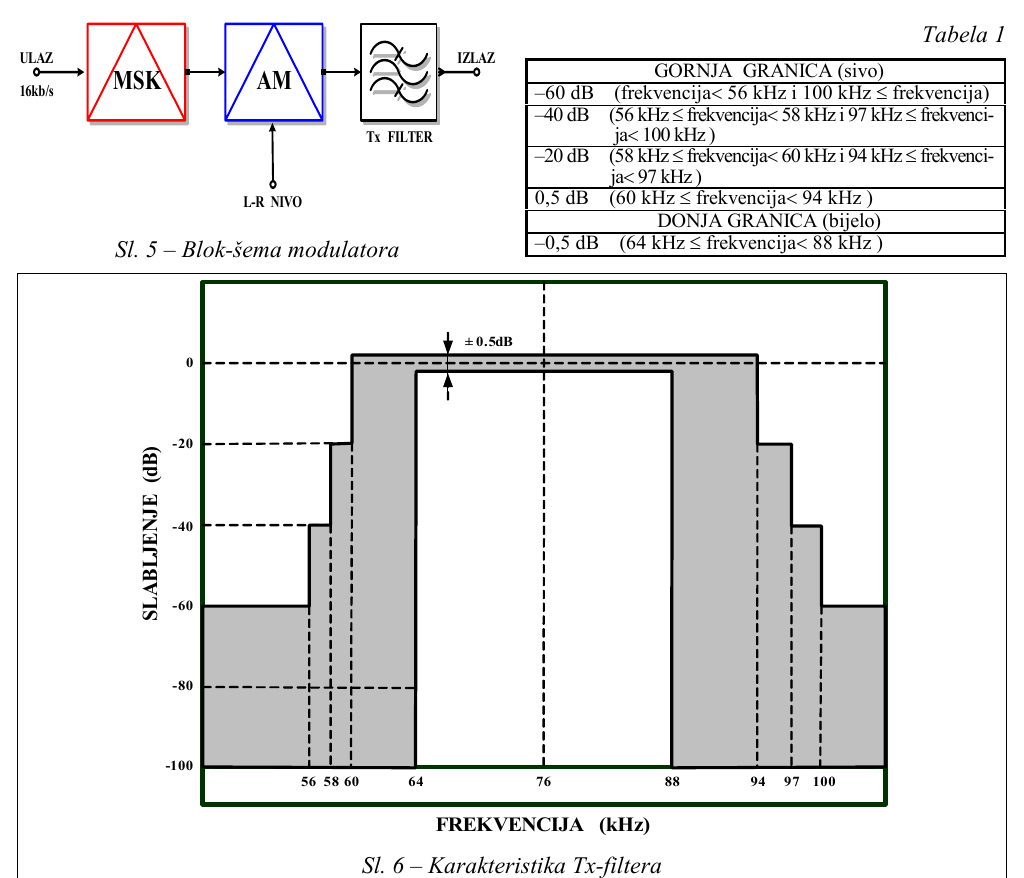
sloj 2. Podnosilac je frekvencije 76 kHz